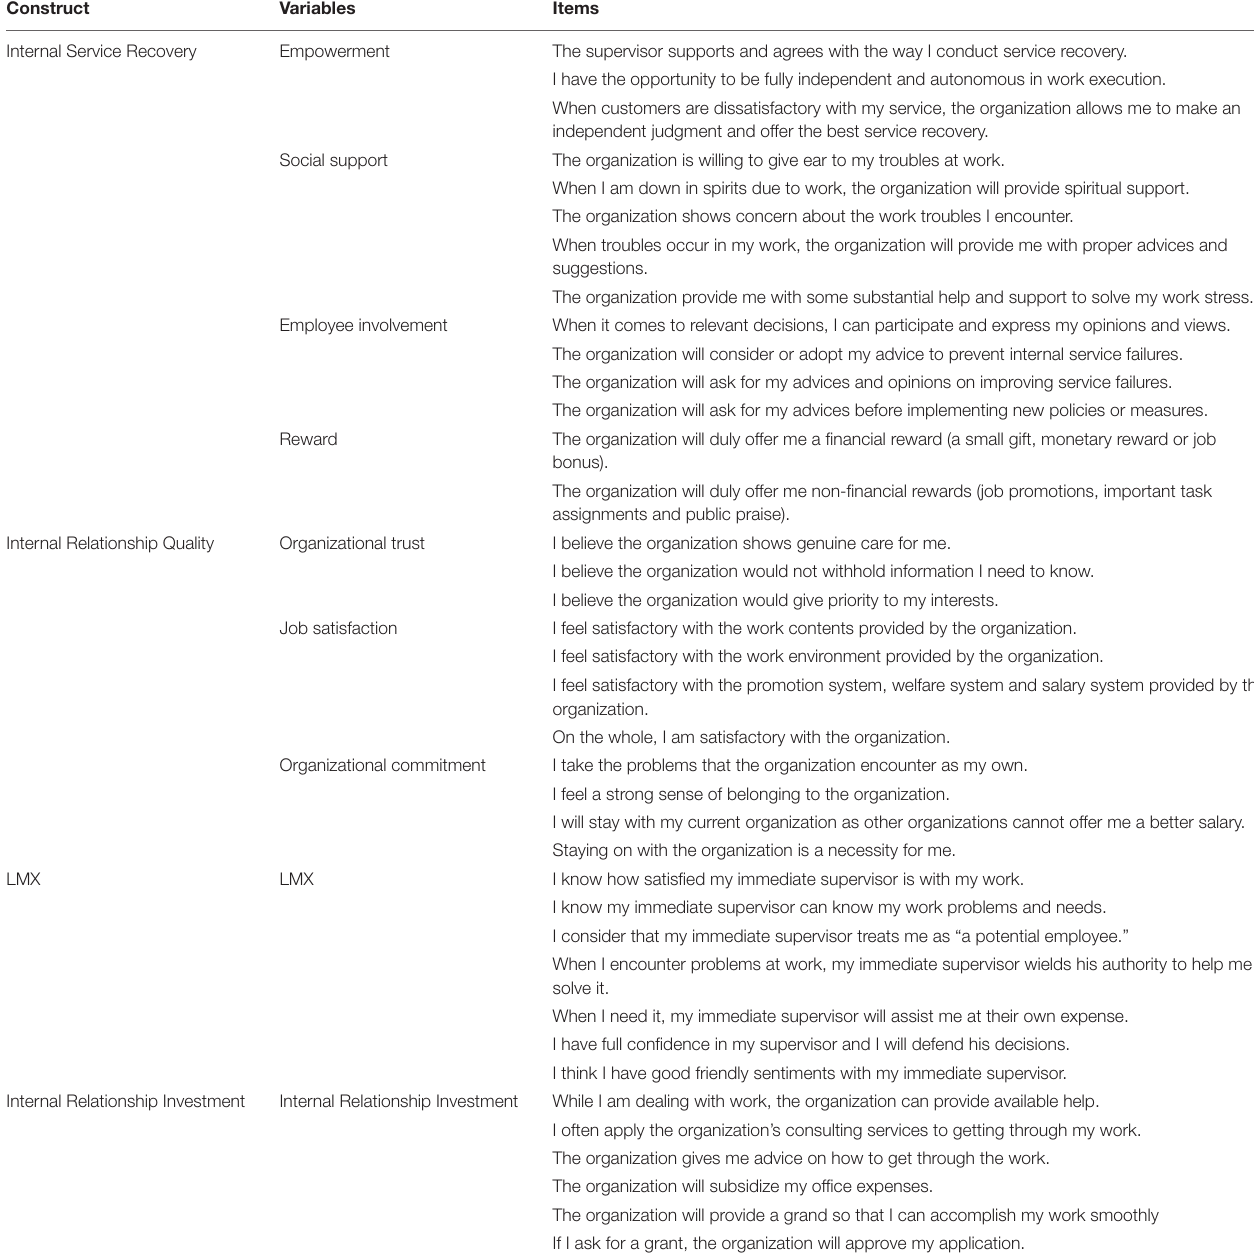
TABLE 2 | Measurement of scale.